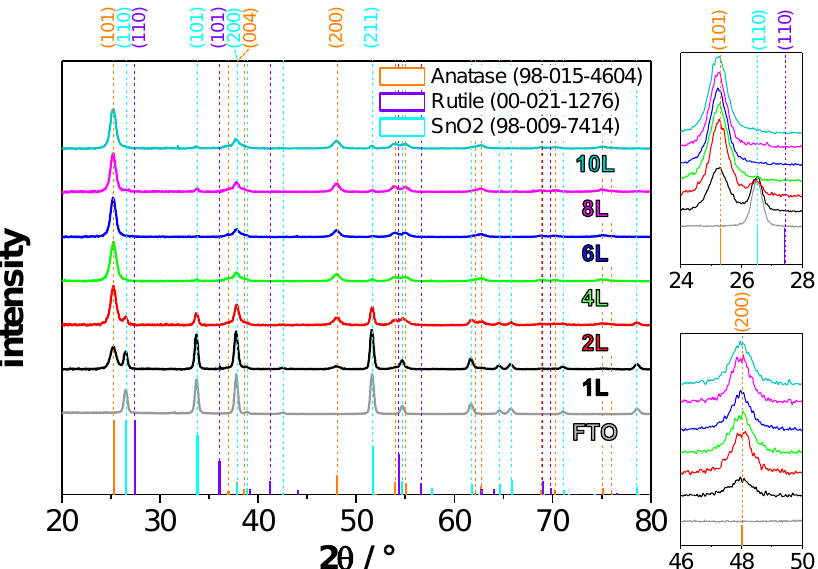
Figure 8. Normalized GI-XRD patterns of multi-layered MTTFs calcined at 550 ◦ C. Reference patterns [82–84] and selected hkl values are displayed for better interpretation.